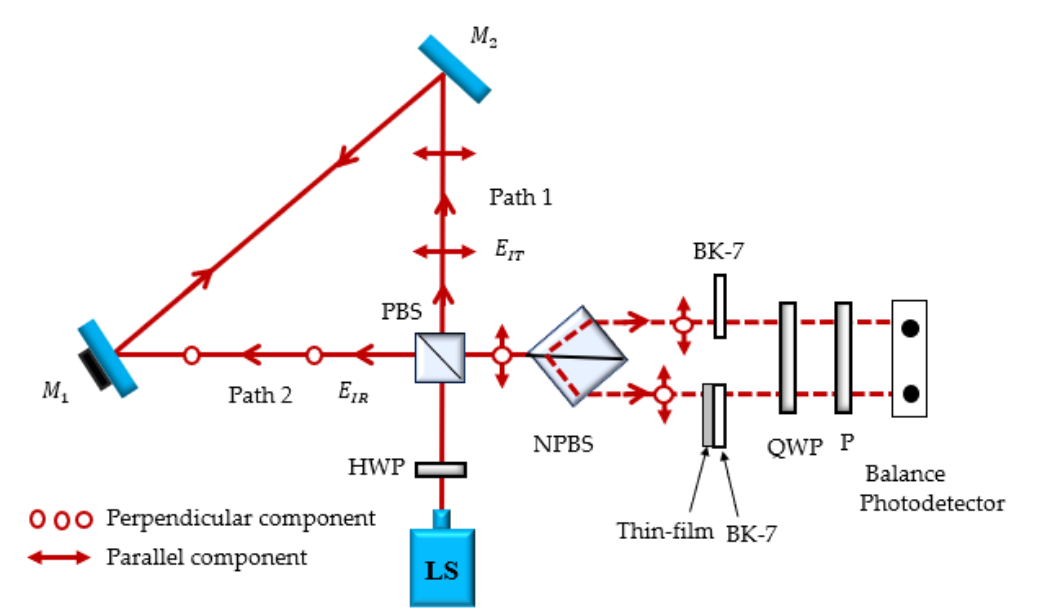
Figure 2. The experimental setup of the proposed modified Sagnac interferometer.